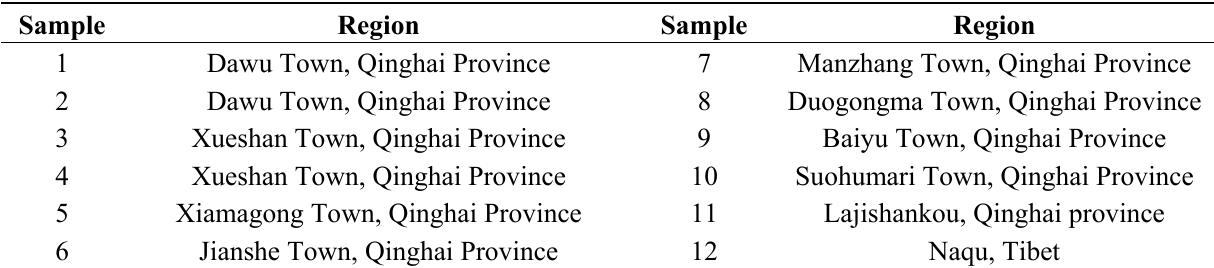
Table 6. Regions of the 12 batches of Cordyceps